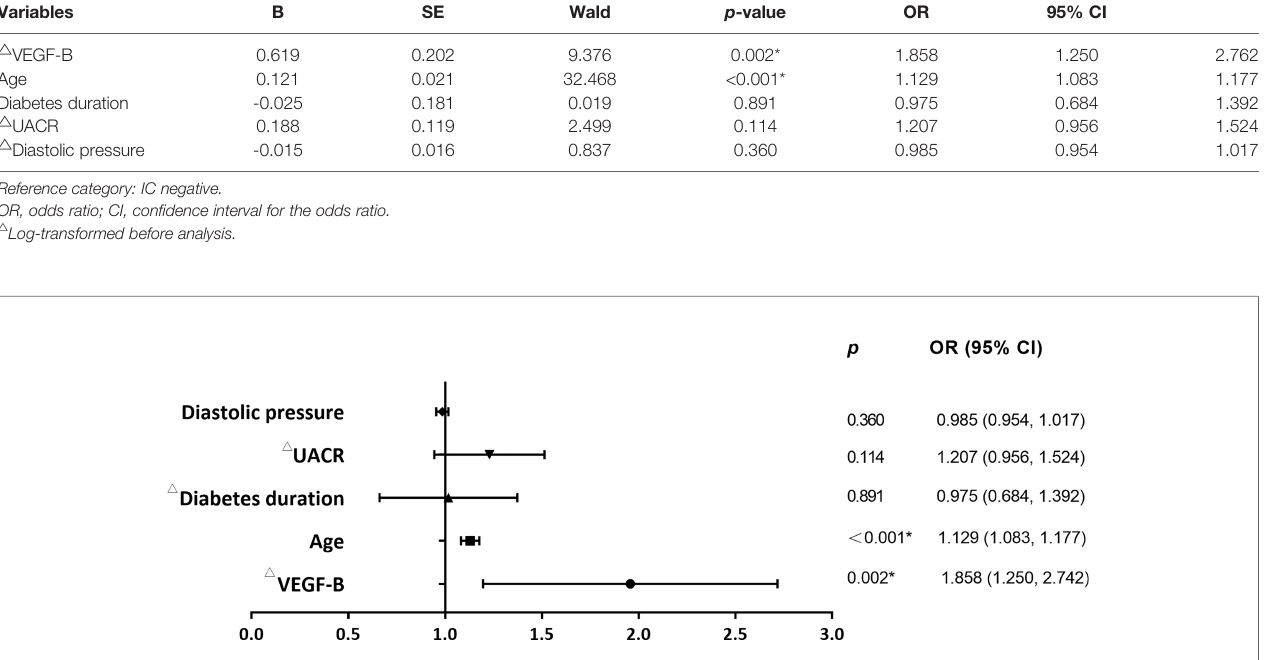
TABLE 4 | Risk factors of eGFR<90 mL/min/1.73m 2 (Binary logistic regression).